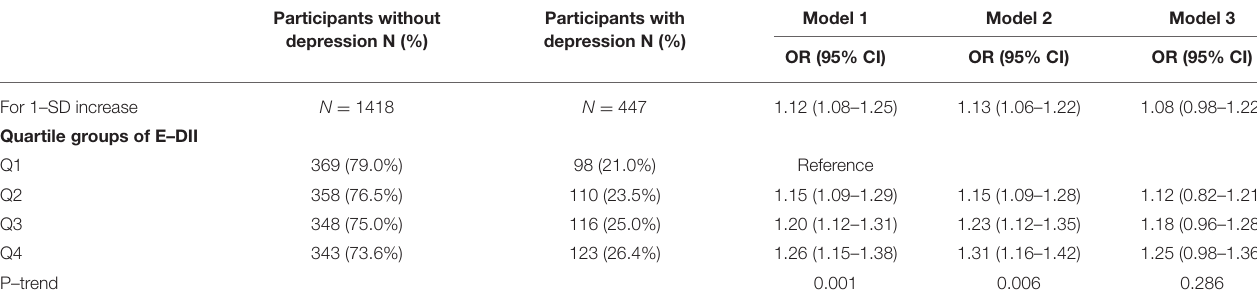
TABLE 2 | Risk of depression according to quartile groups of E–DII ( N = 1865).